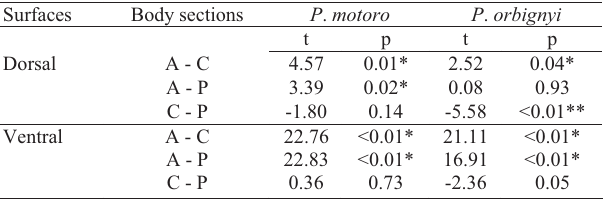
Table 6. Comparisons of the numbers of neuromasts and their densities on the different body sections (A = anterior, C = central, and P = posterior) on both the dorsal and ventral surfaces of Potamotrygon motoro and P . orbignyi . Significant results marked with an asterisk (* = higher in P . motoro